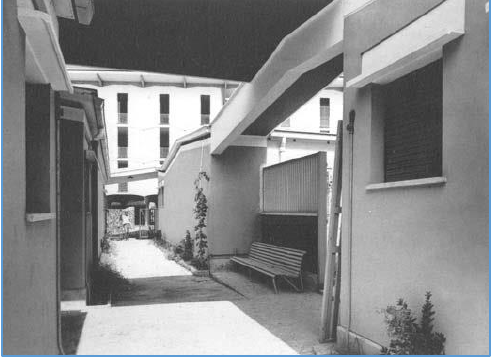
Figure 9. Opened towards outside ‘Patio’ toward pedestrians streets ( Fabrizi,